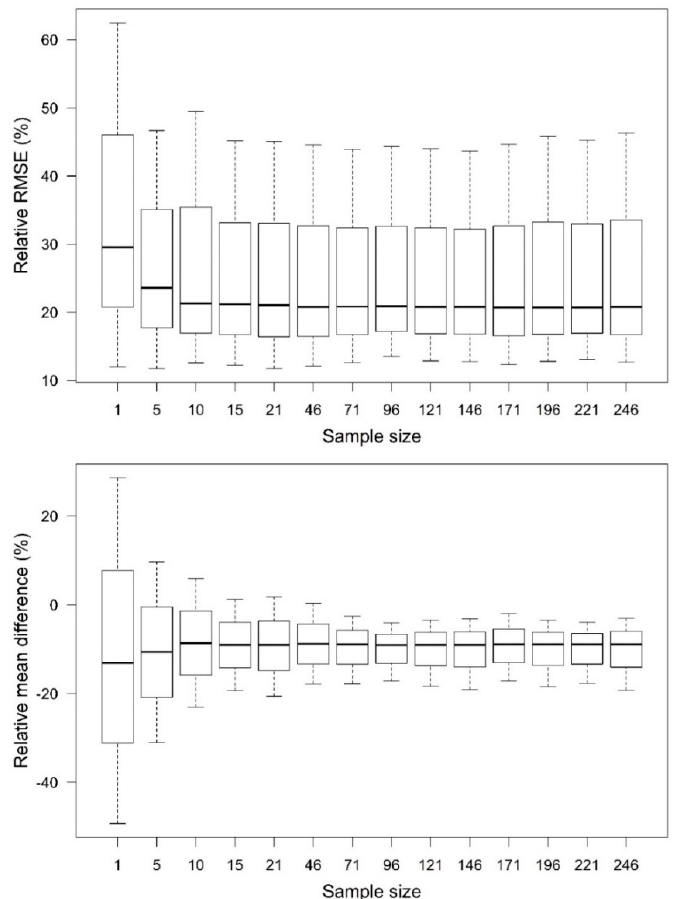
Figure 7. Box plots of relative root mean square error (RMSE) and mean difference of volume estimates based on parametrized taper curves obtained with samples of varying sizes that were randomly selected by 100 times. The box represents first and third quartile (i.e. 25th and 75th percentile), black line the median, and whiskers present the minimum and maximum of the relative RMSE and mean difference of stem-volume estimates.